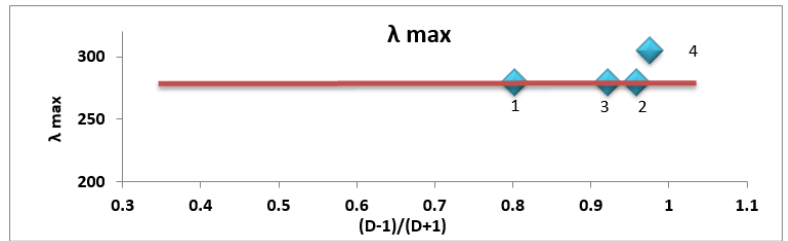
Fig. 6. The relation between the dipole moment constants and the maximum wavelengths of (A 3 ) using different solvents(1- Chloroform , 2- DMSO, 3- Ethanol, 4- Methanol.) Further, the pH effect in the range of 𝜆 (250-500) nm was also studied for each schiff base (A 1 ), (A 2 ) and (A 3 ) in a range